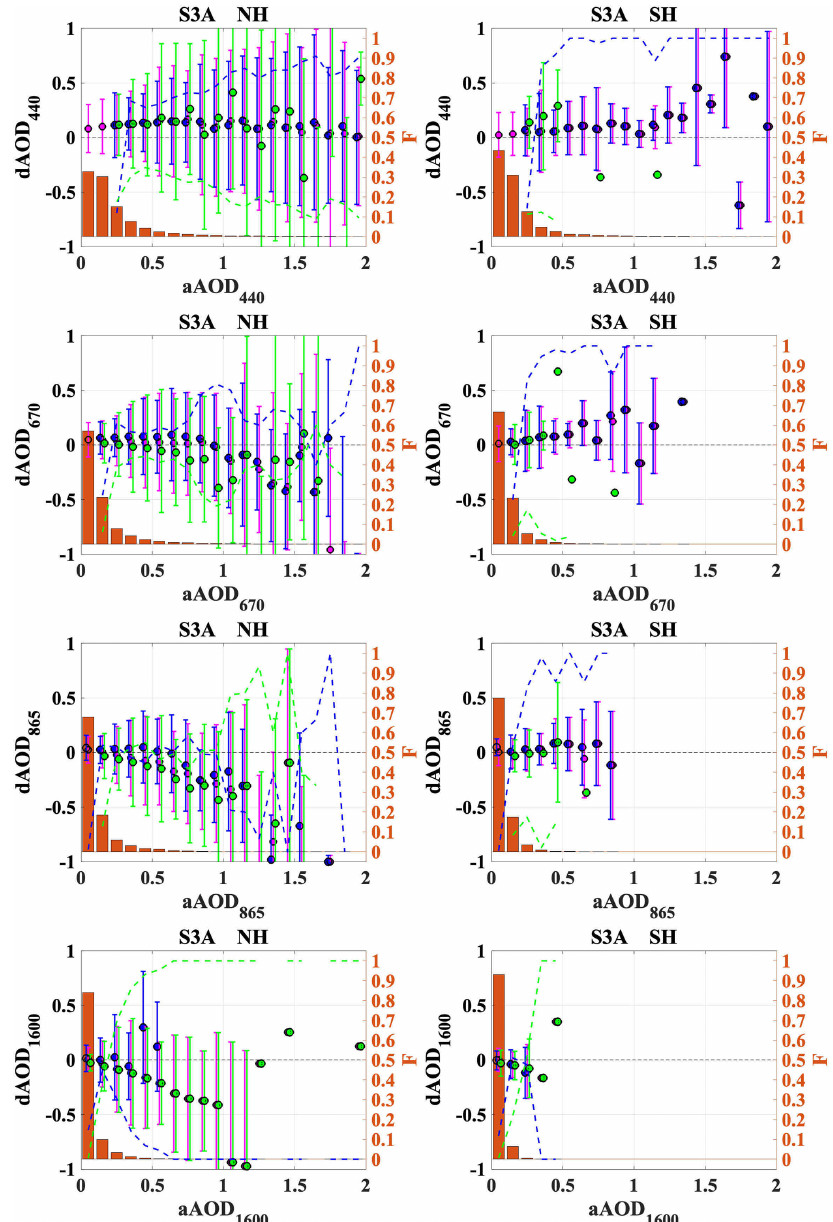
Figure 13. For the NH (left) and SH (right) for different wavelengths (top down: 440, 670, 865, 1600nm), the difference (dAOD 550 ) between syAOD and aAOD for selected aAOD bins: median bias (circles) and bias standard deviation (error bars) for all (incl. background, aAOD 550 ≤ 0.2) AOD types (purple), as well as aerosol fine-dominated AOD (blue) and coarse-dominated (green) AOD. The fraction ( F ) of fine-dominated matchups from the total number of matchups in each bin is represented by orange bars. The fractions of fine- and coarse- dominated matchups in each bin are shown as blue and green dashed lines,